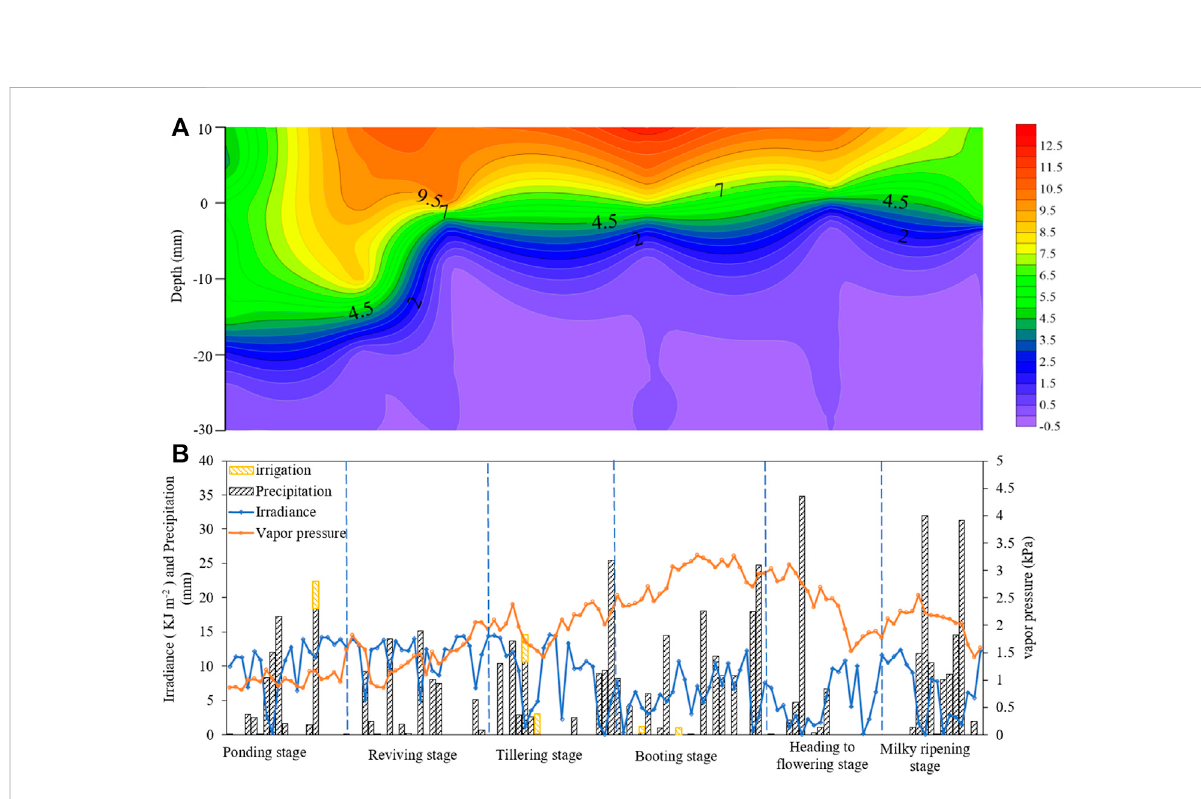
FIGURE 3 (A) Soil vertical DO concentration distribution and (B) meteorological factors during the whole growth